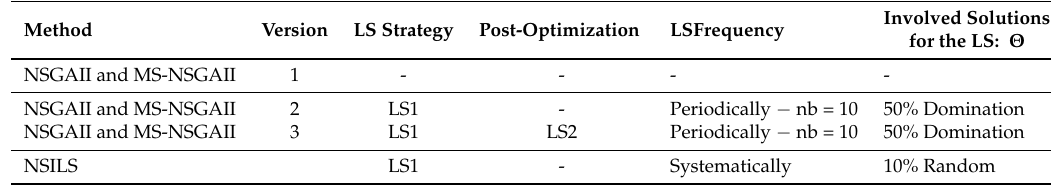
Table 7. Non-dominated sorting versions.